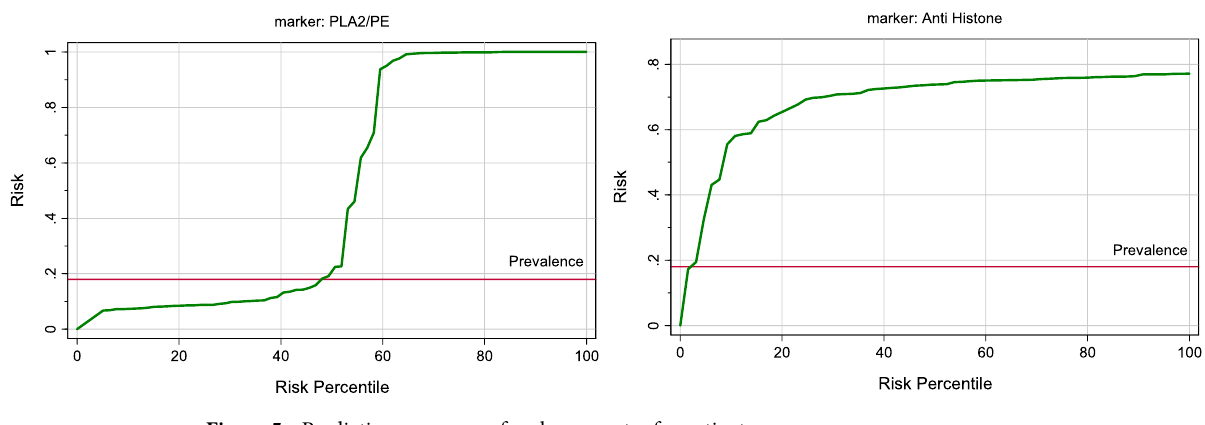
Figure 5. Predictiveness curve of each parameter for patient group.